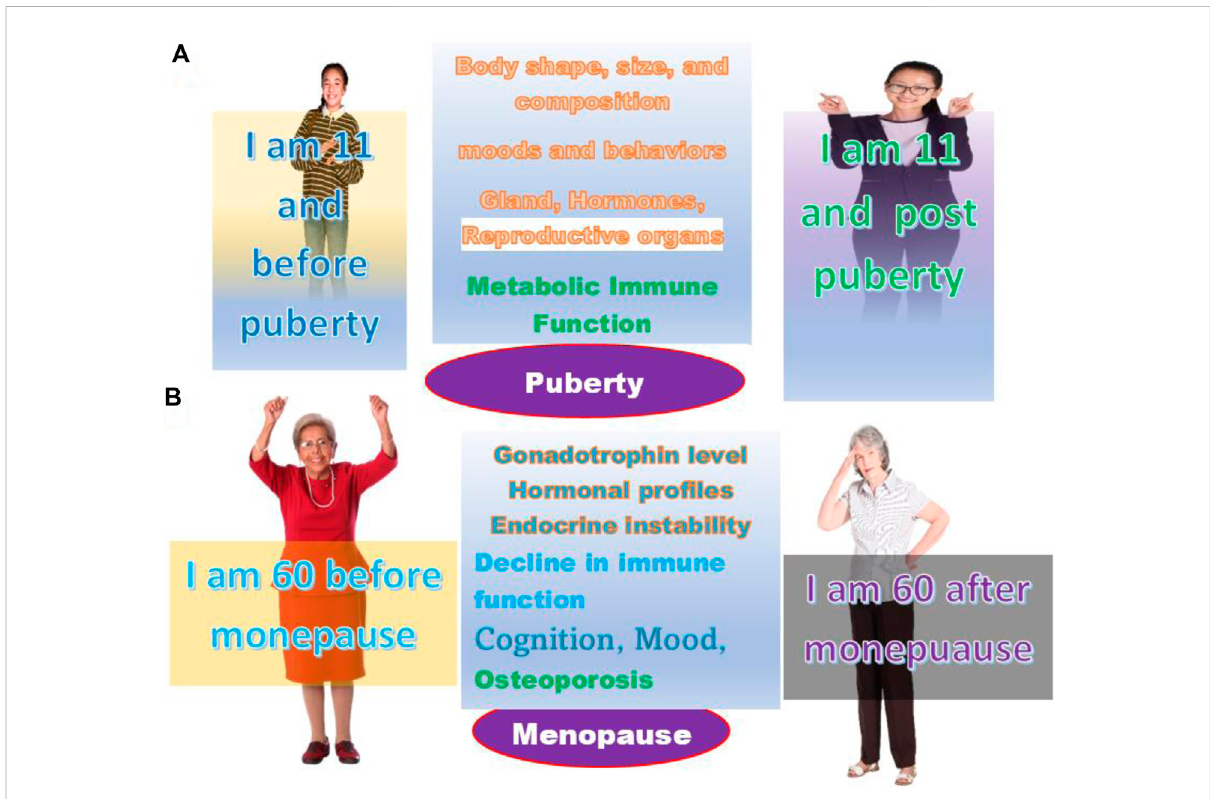
FIGURE 4 Theage andlifestageare notalways thesame. (A) Persons ofthesameagemay beatthelifestageofbefore orafter puberty. (B) Personsofthe same age may be at the life stage before or after